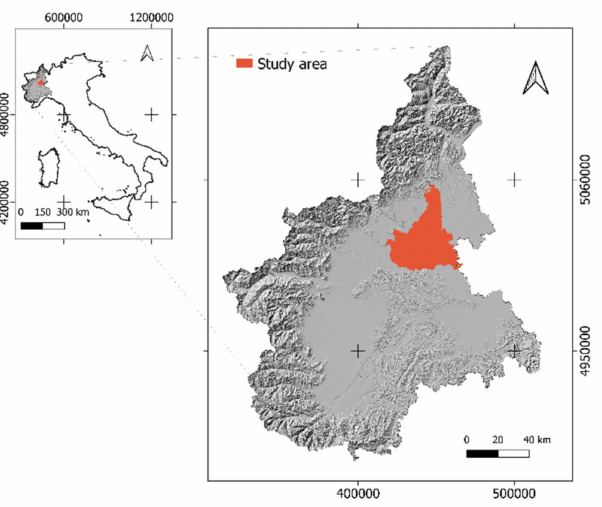
Figure 1. Study area ( red ) located in the southern part of the province of Vercelli in the Piemonte Region, NW Italy. (Reference system is WGS84/UTM 32N, EPSG: